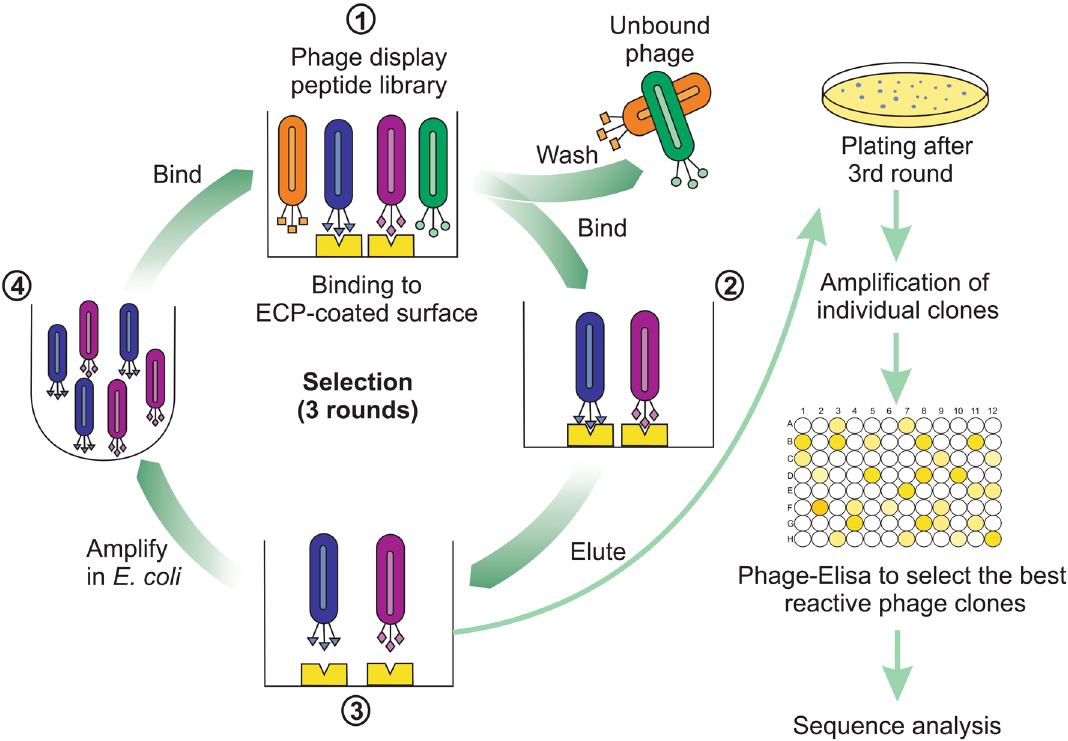
Figure 1. A scheme of the biopanning experiment. Phage library was incubated with Eosinophilic Cationic Protein (ECP) coated on surface. Unbound phages were washed and phages bound to ECP were eluted and amplified for next round of biopanning. After the 3rd round the eluate was plated and individual clones were amplified. Then, the most reactive phage clones were selected by Phage-ELISA for sequencing